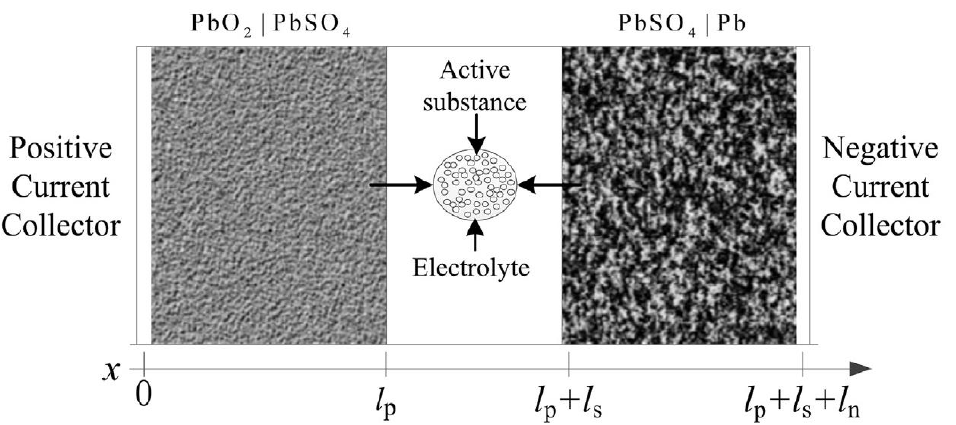
Figure 4. Schematic diagram of a lead-acid battery [50]. Reprinted with permission from Ref. [50]. 2016, Elsevier.